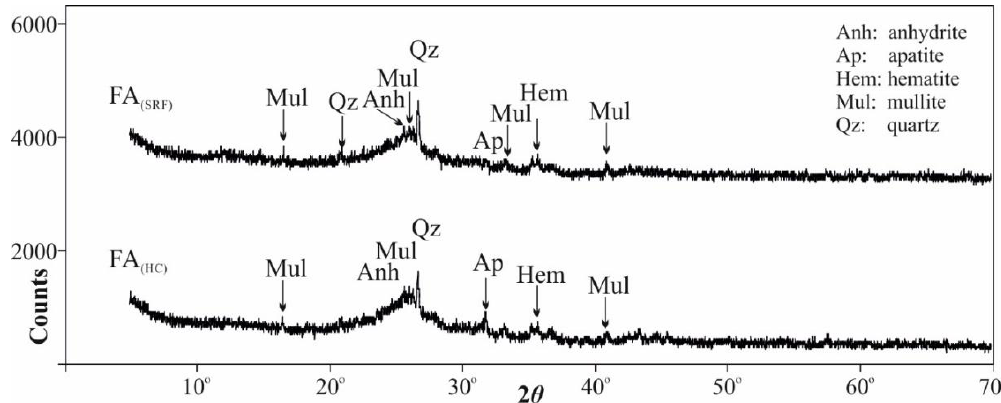
Figure 2. X-ray diffractograms of the studied fly ash samples. Table 3. Quantitative mineralogical data of the studied fly ashes (in % of crystalline